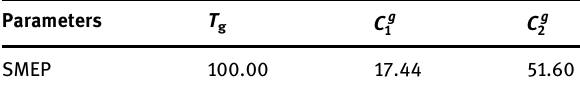
Table 1: Fitting results of WLF parameters